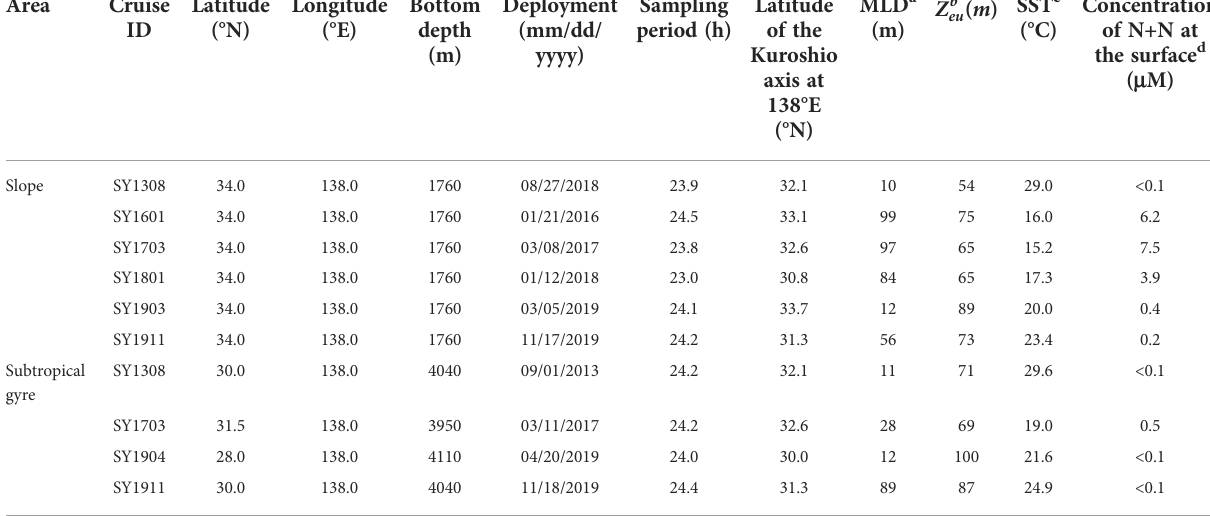
TABLE 2 Locations of sampling sites and oceanographic settling during the drifting sediment trap